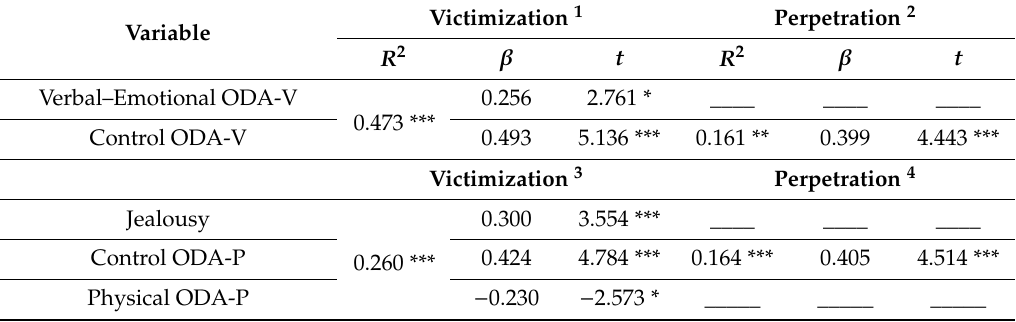
Table4. MultilinearregressionanalysisassessingthecontrolCDAvictimizationandperpetrationassociations.